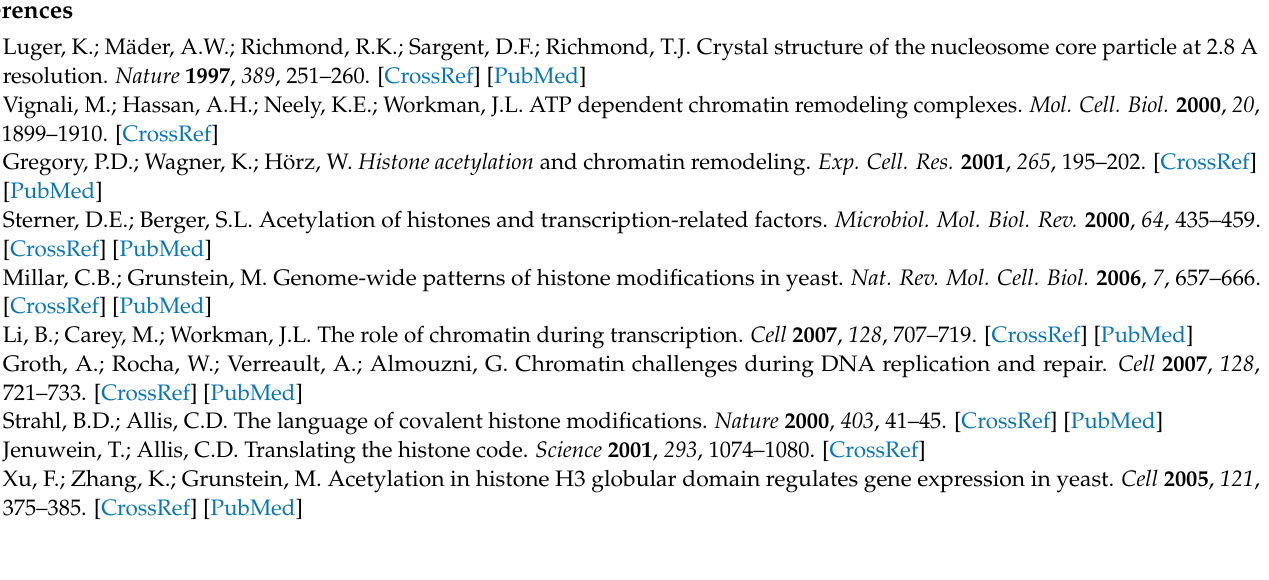
Table S9: Summary of 67 DEGs enriched in 39 KEGG pathways in B. bassiana ∆ Spt10 mutant versus WT. Table S10: Summary of the top 20 upregulated genes and the top 20 downregulated genes in ∆ Spt10 versus